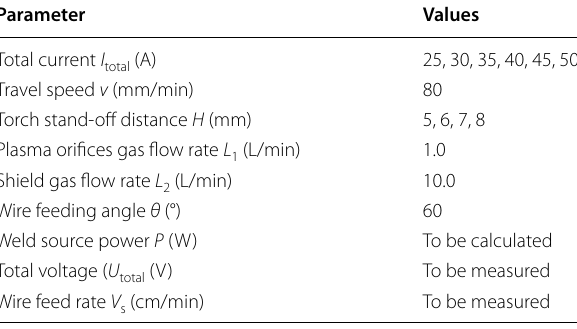
Table 2 Processing parameters and their